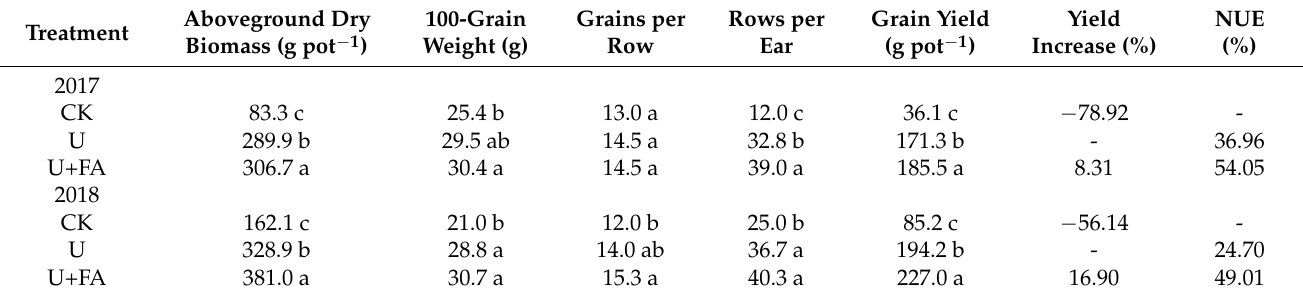
Table 2. Maize aboveground dry biomass, yield and yield components, and nitrogen use efficiency (NUE) in different fertilization